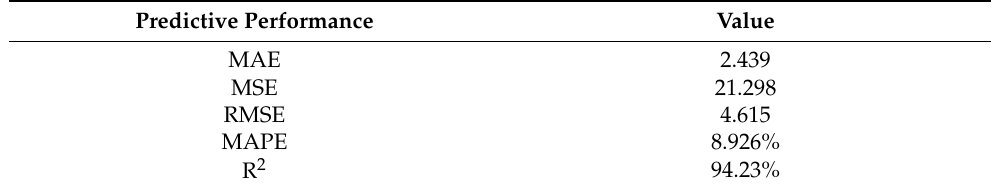
Table 5. Performance evaluation summary table.